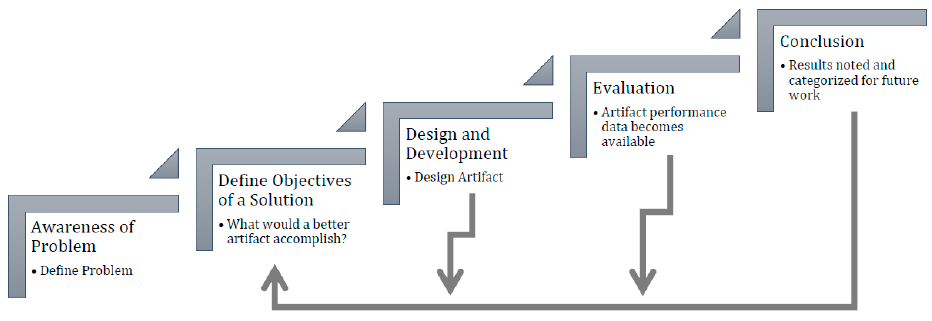
Figure 1. Design science research process model based on [21] and [22].